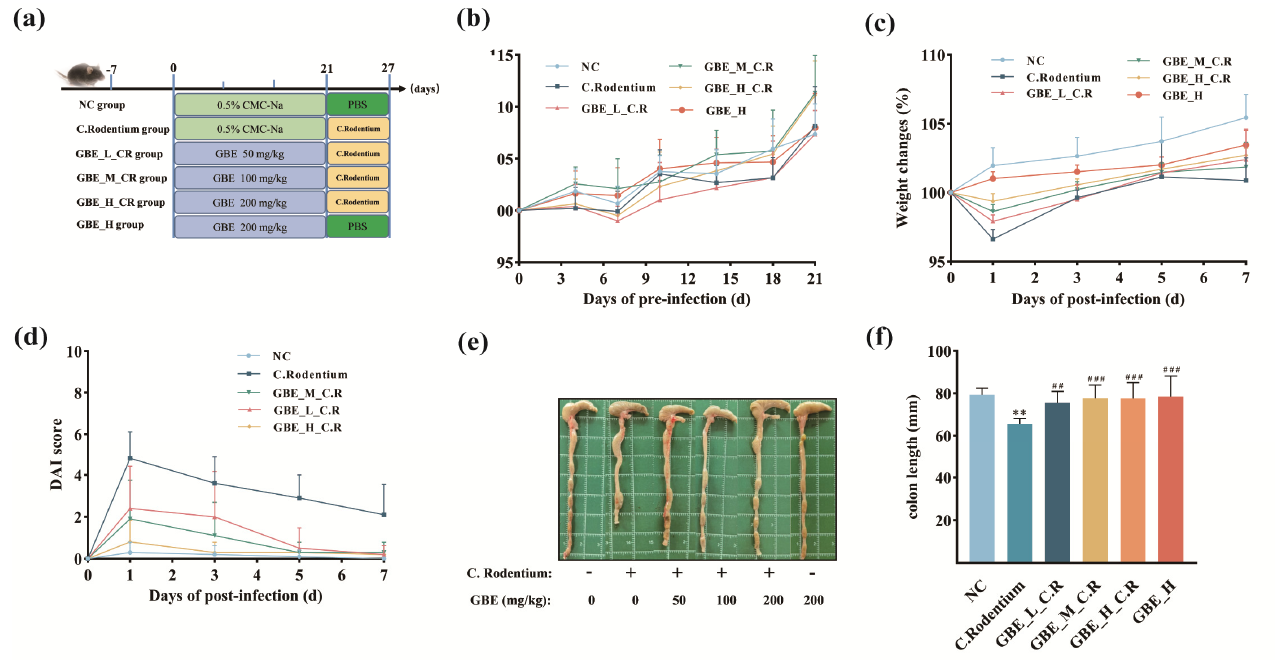
Figure 2. GBE ameliorated the CR-mediated colitis symptoms in mice. ( a ) Experimental design grouping and treatment (n = 10 per group). ( b ) BW changes before CR infection. ( c ) BW changes after CR infection. ( d ) DAI scores. ( e , f ) Colon lengths. ** p < 0.01 vs. NC group; ### p < 0.001 an ## p < 0.01 vs. C. Rodentium group.